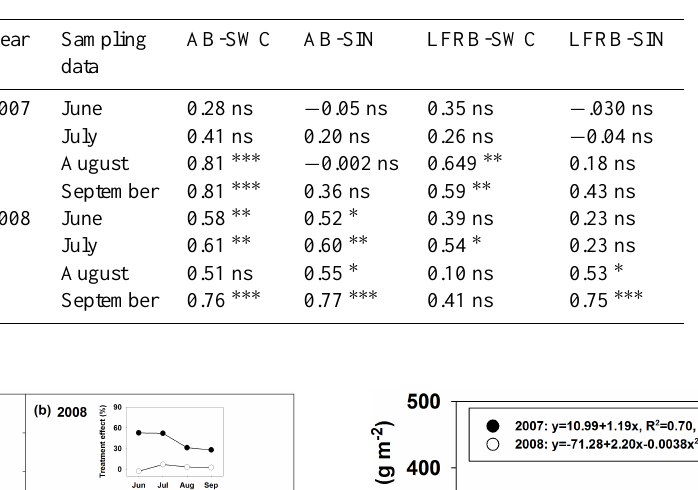
Table 4. Correlation coefficients for plant biomass and soil water and nutrient content in 2007 and 2008. ∗ , ∗∗ and ∗∗∗ indicate significant level at P < 0 . 05, P < 0 . 01, and P < 0 . 001, respectively; ns is non-significant. Abbreviations: AB for aboveground biomass, LFRB for live fine root biomass, SWC for soil water content, and SIN for soil inorganic N content.